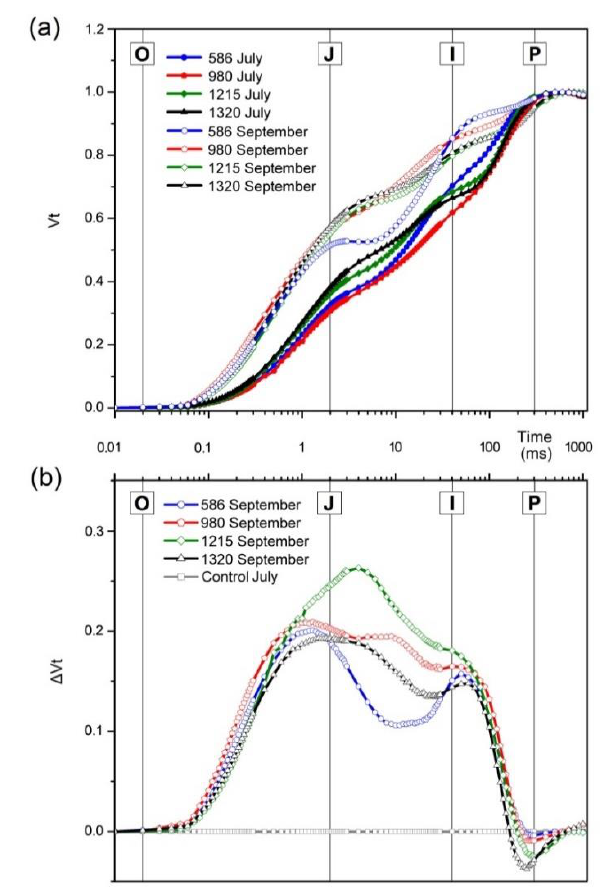
Figure 1. Normalized fluorescence induction curves (Vt) of Chl a fluorescence of green alder ( Alnus viridis ) leaves recorded in July (filled points) and September (empty points) in localities at different elevations, 586, 980, 1215, and 1320 m a.s.l. ( a ) The differential fluorescence curves ( ∆ Vt) obtained by subtracting the Chl a fluorescence values on the O-P phase from all field sites ( b ), as described in Methods.